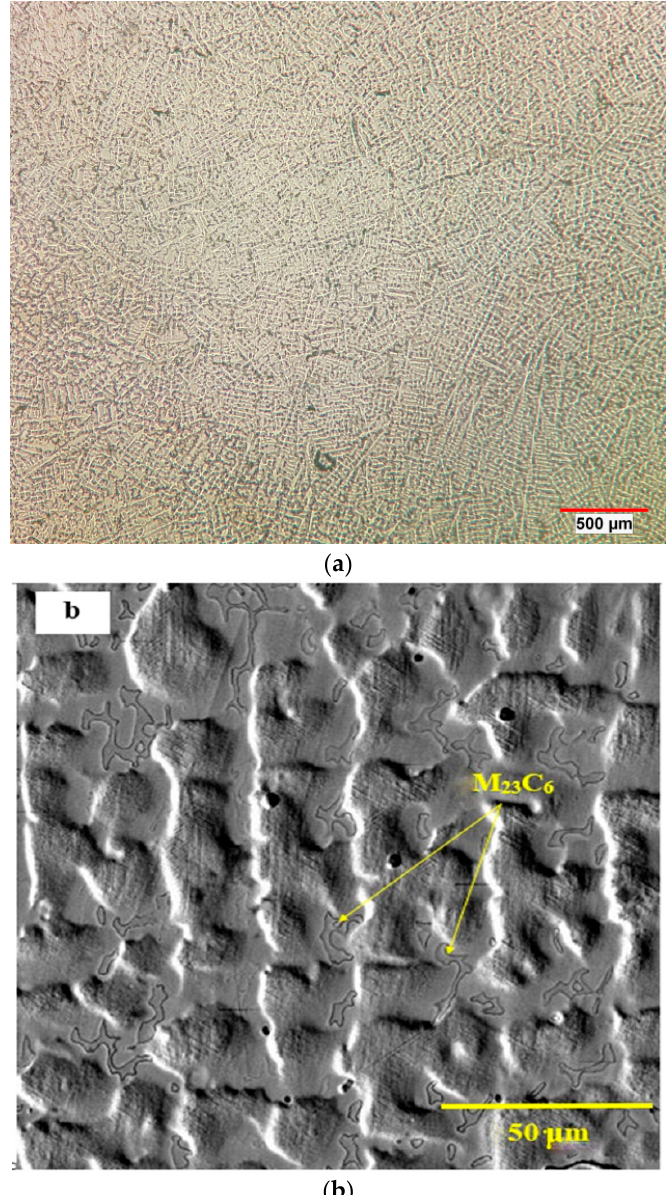
Figure 1. ( a ) Optical microscopy OM micrograph of the as-cast sample contained dendrite microstructure, and ( b ) Scanning electron microscopy (SEM) micrograph of the primary carbides.